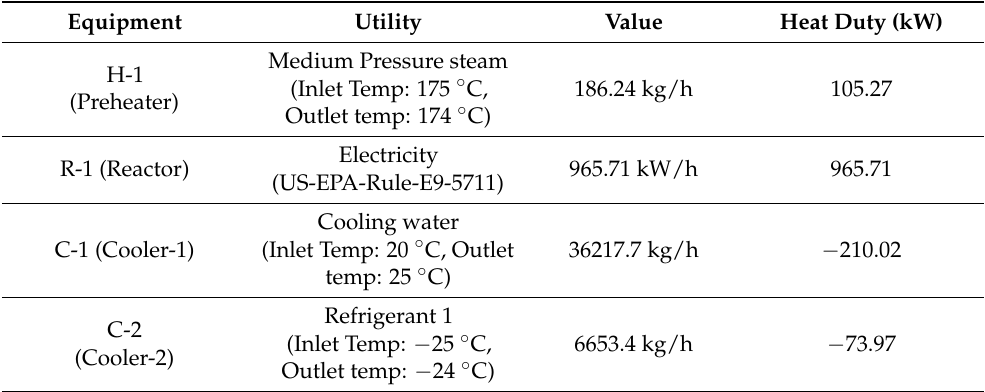
Table 4. Utility data for the hydrocracking